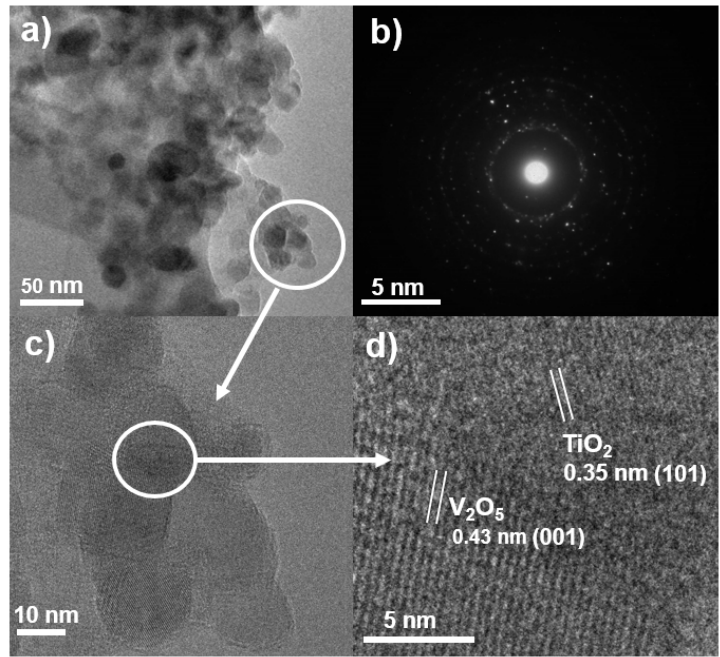
Figure 5. ( a ) Transmission electron microscope image, ( b ) selected area electron diffraction pattern, ( c ) high-resolution transmission electron microscopy image, and ( d ) partial enlargement of the TiV-3 sample.